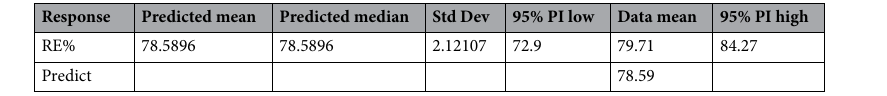
Table 6. Confidence interval of efficiency prediction.